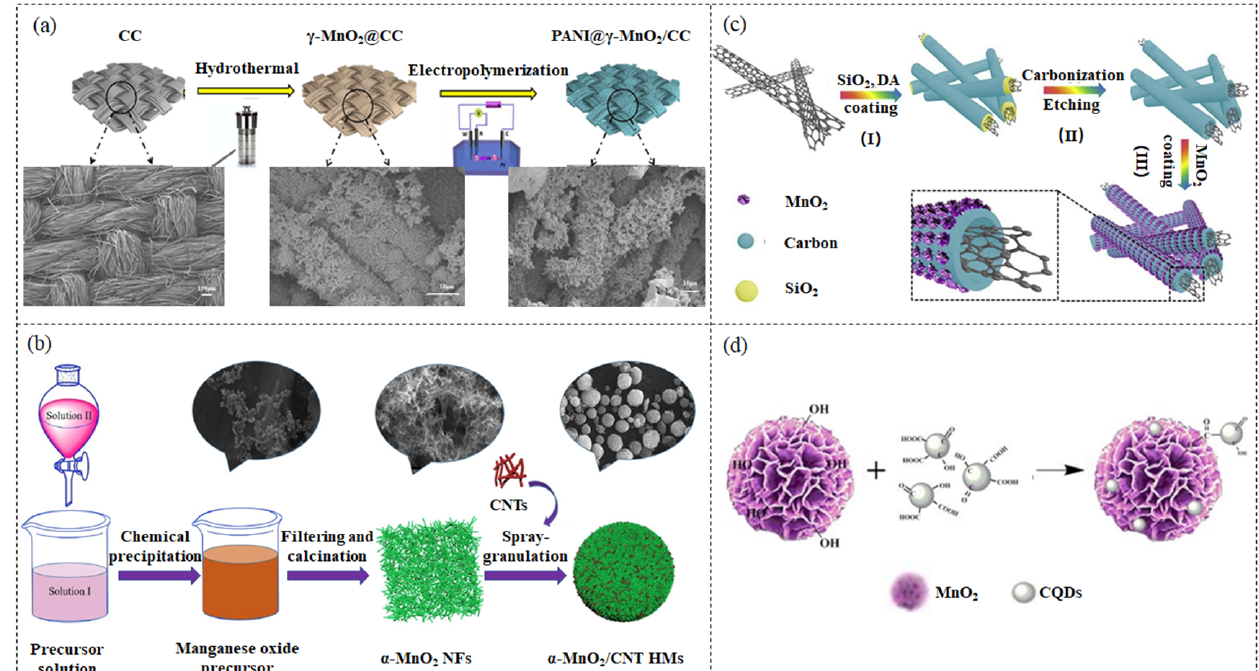
Figure 2. ( a ) The schematic diagram of the process of preparing ternary composite PANI@ γ− MnO 2 /CC composite materials and SEM images of different materials. Figures reprinted with permission from ref. [147]. Copyright 2022; Elsevier Ltd. ( b ) Schematic illustration of the preparation of α− MnO 2 /CNT HMs and SEM images at different synthetic stages. Figures reprinted with permission from ref. [149]. Copyright 2019; Elsevier Ltd. ( c ) Schematic illustration of the fabrication of CNT@NCT@MnO 2 composites. (I) CNTs were sequentially coated with a thick SiO 2 layer and carbon layer; (II) the removal of the SiO 2 layer; (III) the growth of ultrathin MnO 2 nanoflowers on the carbon layer. Figures reprinted with permission from ref. [150]. Copyright 2019; Elsevier Ltd. ( d ) Schematic representation of the preparation of CQDs/MnO 2 nanoflowers. Figures reprinted with permission from ref. [151]. Copyright 2017; Electrochemical Society.